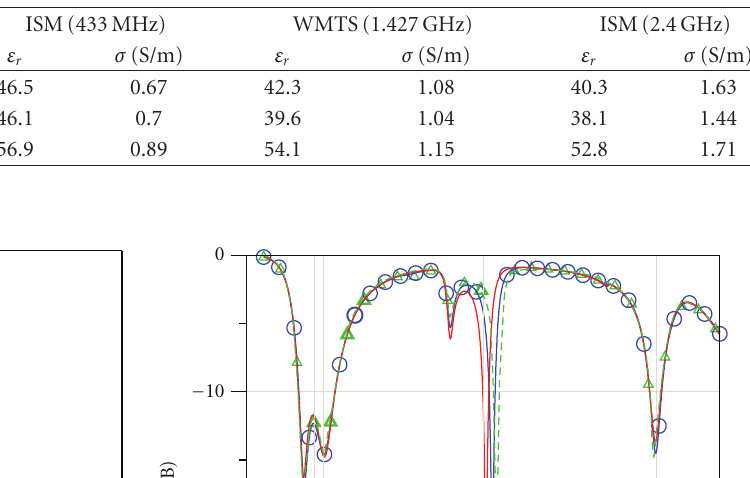
Table 1: Comparison of electrical properties of tissues at MedRadio, WMTS, and two ISM bands.